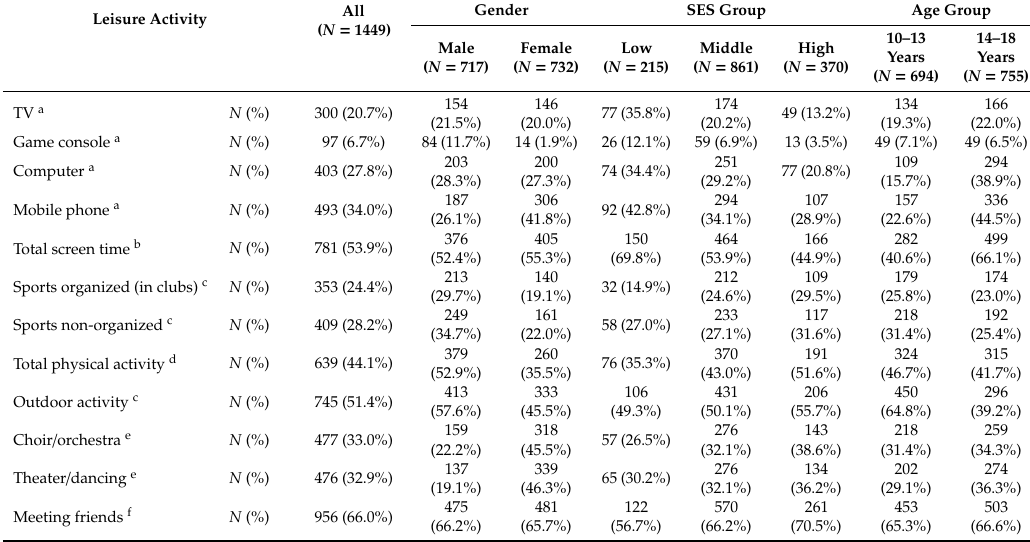
Table 1. Distribution of leisure activities among healthy children in the LIFE Child study cohort ( N = 1449).